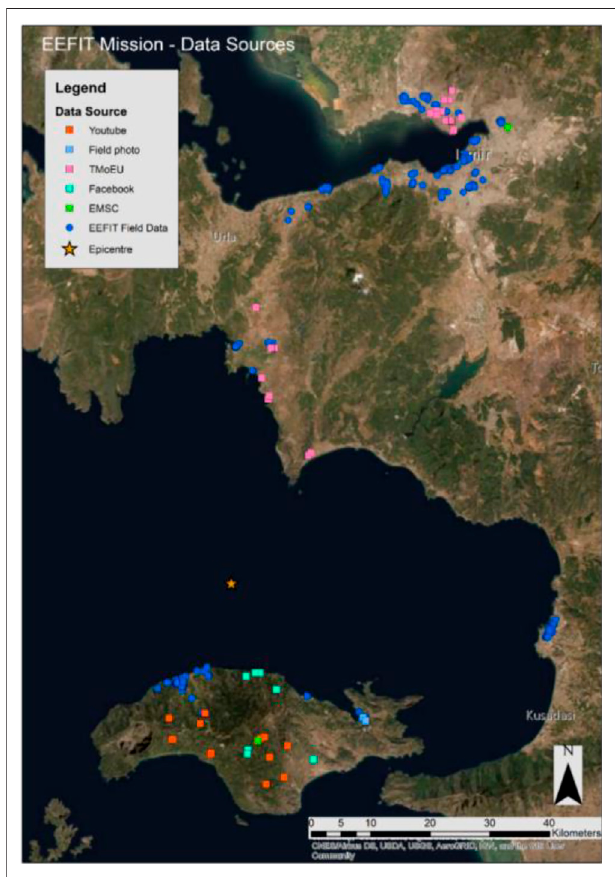
FIGURE 5 | Distribution of the data sources used for damage assessment in this study.